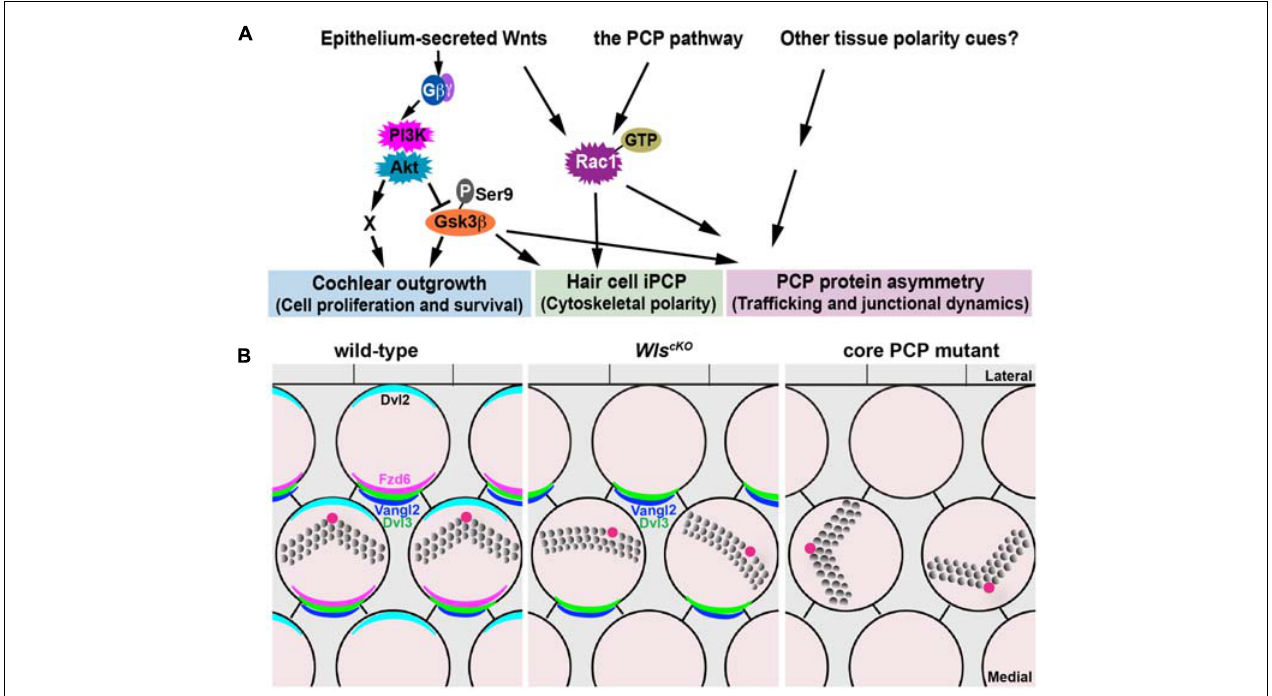
FIGURE 8 | Non-canonical Wnt and PCP pathways act in concert to regulate cochlear morphogenesis. (A) A working model for the concerted actions of the non-canonical Wnt and PCP pathways in regulating different aspects of cochlear morphogenesis. (B) Schematic diagrams comparing PCP defects in the Wls cKO and core PCP mutant OC. Kinocilium (the red dot) positioning at the hair bundle vertex was disrupted in Wls cKO but not core PCP